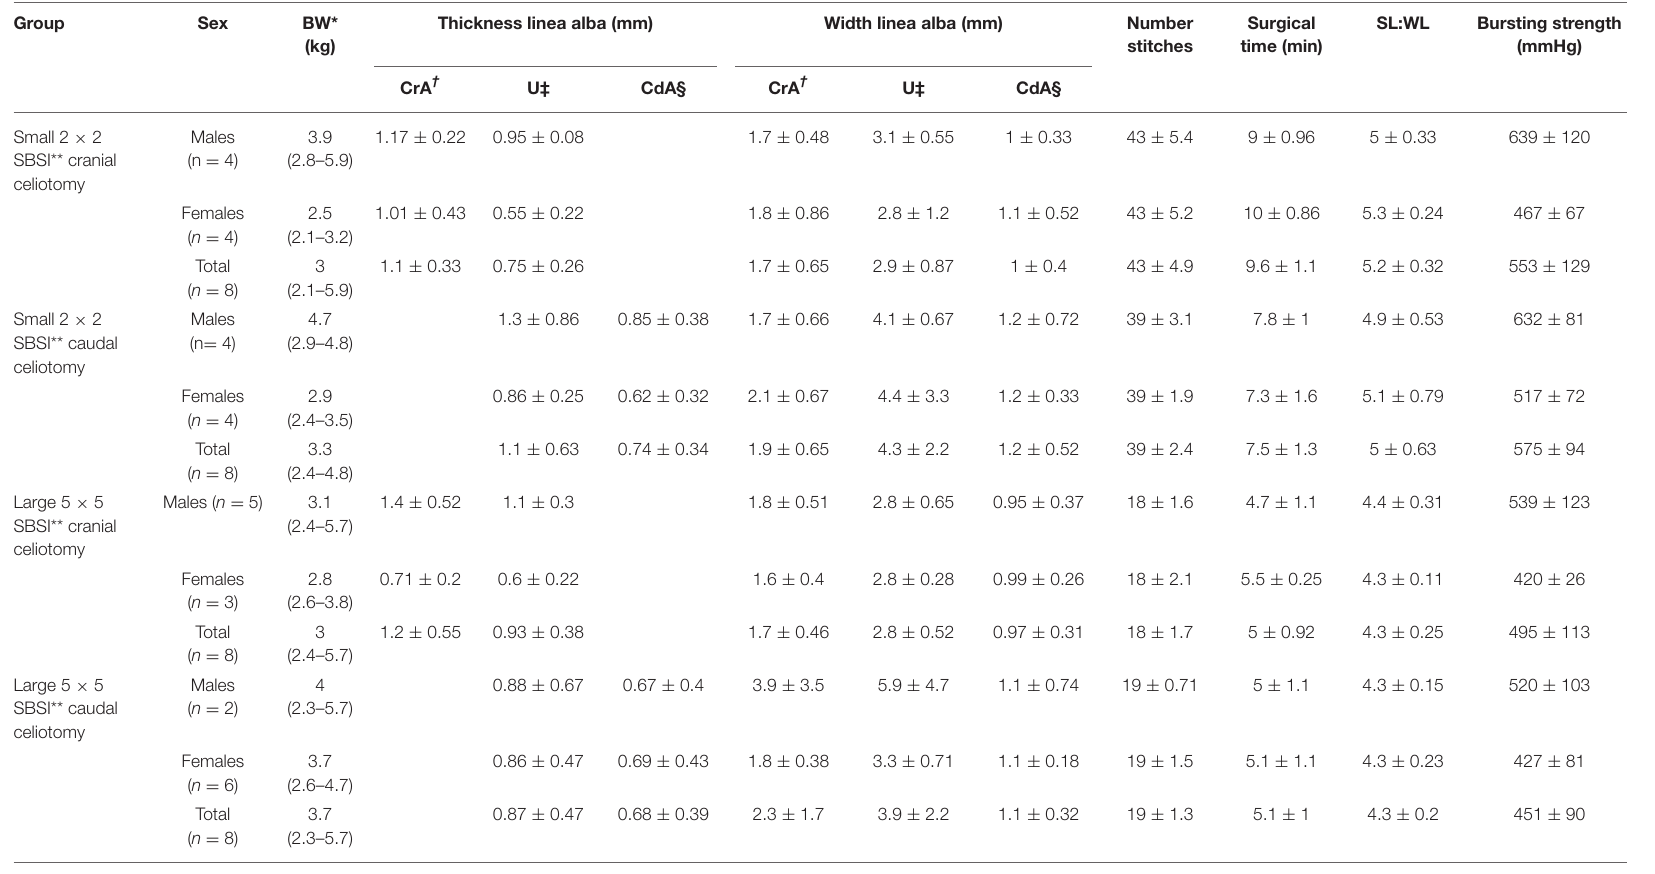
TABLE 1 | Summary of the data for the 32 specimens.